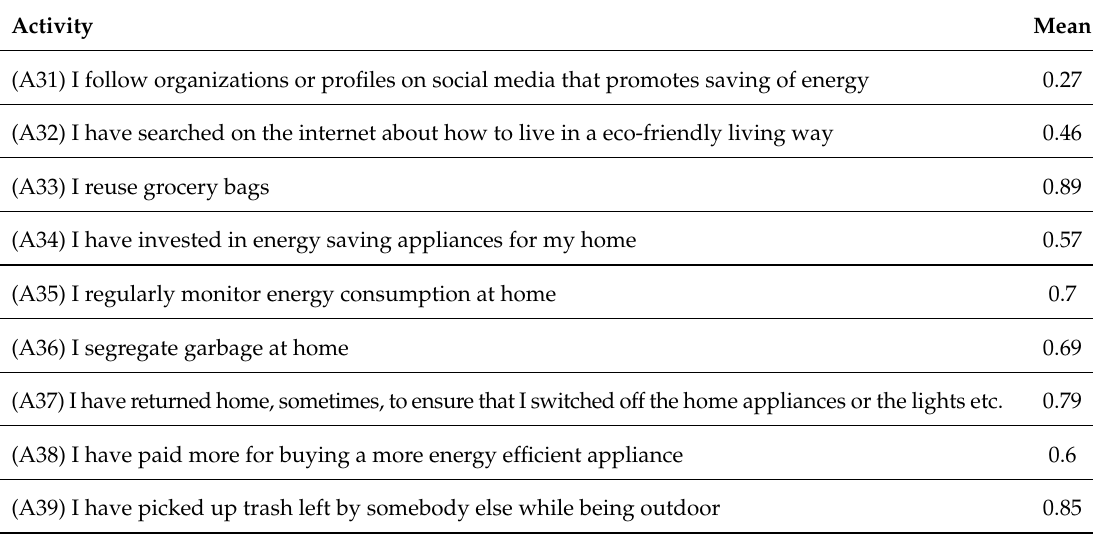
Table 5. Mean values of variables A31–A39 (N =